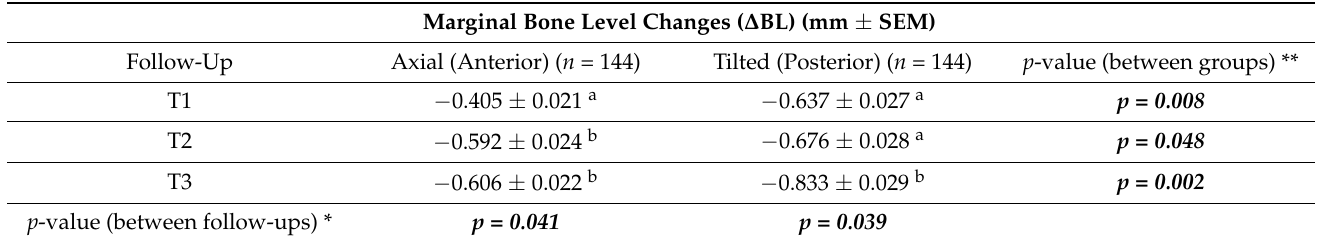
Table 2. Marginal bone-level changes around axial and tilted implants during the 42-month study